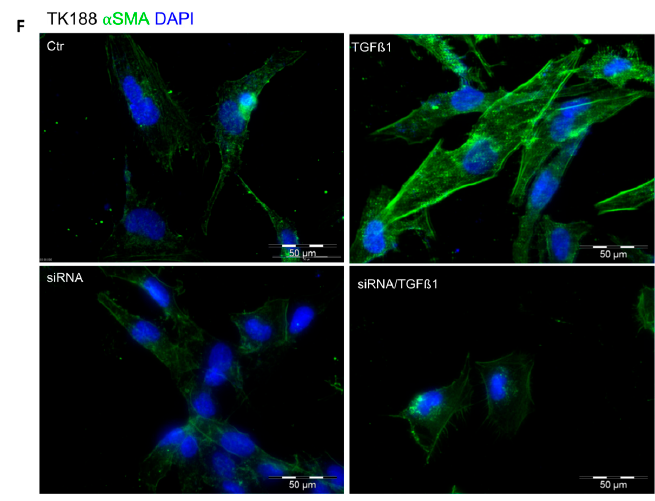
Figure 7. PPIA downregulation resulted in significant alteration of PPIA secretion, ⍺ SMA expression, and ECM synthesis and secretion. To achieve 3D cell culture conditions, renal fibroblasts were cultured on collagen I-coated surface, TK173 and TK188 controls and siRNA treated were stimulated with TGF β 1 for 48 h. ( A , B , D , E ) Proteins were enriched from TK173 and TK188 cell extracts or supernatant as described in Section 2. The Western blots were performed with antibodies against PPIA, (cid:31)SMA, FN1. In case of cell extract ACTB was used as a loading control. Bar diagram representing the quantification of the Western blot results for cell extract data is presented as the ratio of the PPIA/ACTB or FN1/ACTB ( n = 4, * p < 0.05). For secretome samples, the data are presented in intensity (%). ( C , F ) Renal fibroblasts cell lines were treated with TGF β 1 or TGF β 1 combined with siRNA against PPIA for 48 h. After the fixation with paraformaldehyde, the cells were stained with antibodies against (cid:31)SMA. * p < 0.05, ** p < 0.01, *** p < 0.001 ns: non-significant.